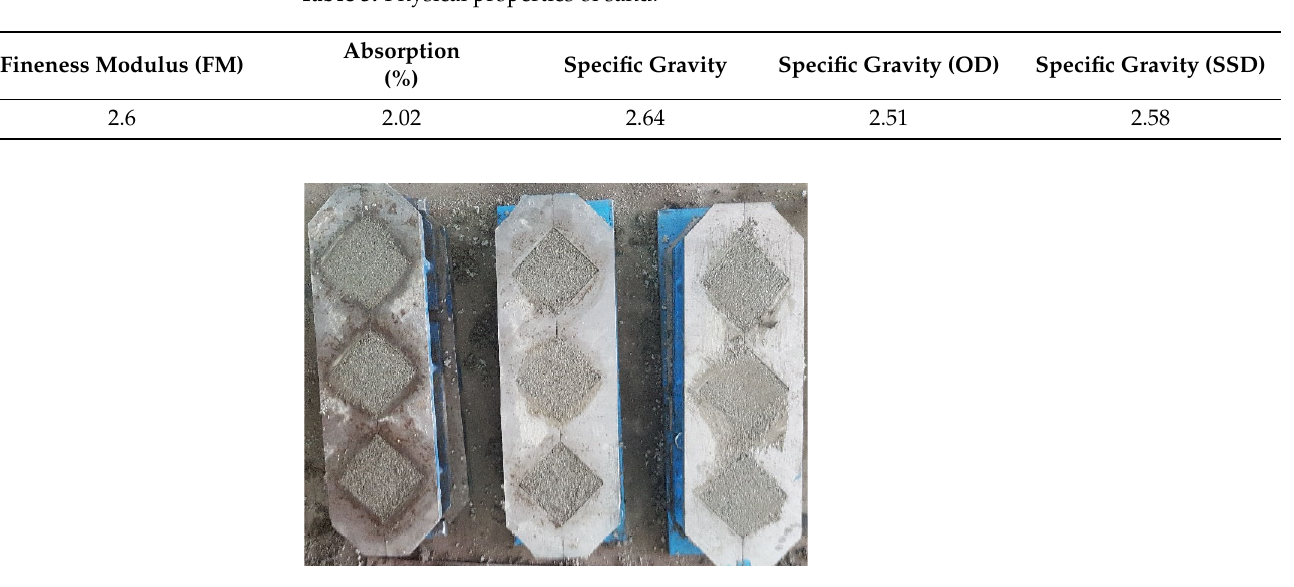
Figure 4. Preparation of Mortar samples .